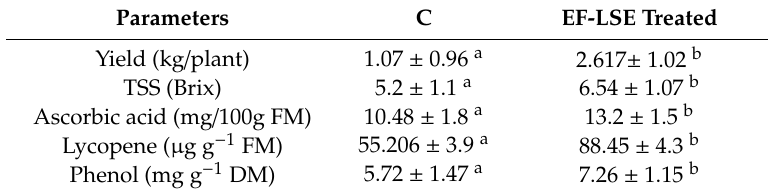
Table 5. Yield, TSS, Ascorbic acid, lycopene and phenol contents of treated cherry tomato fruits.